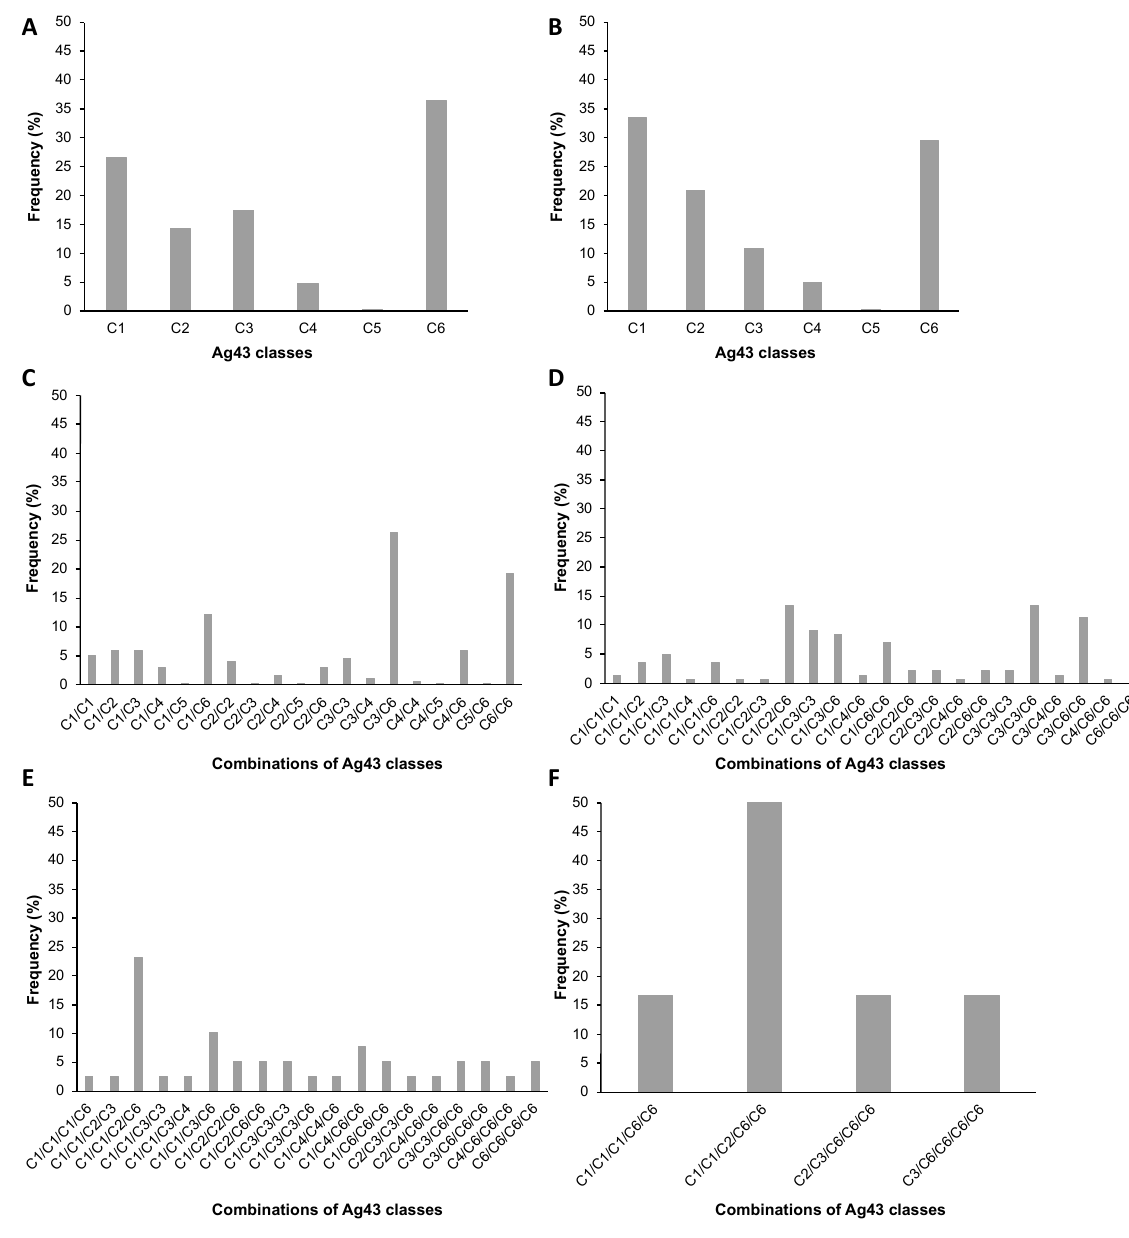
Figure 9. Prevalence and distribution for the different combinations of the 6 Ag43 classes in Escherichia genomes. Representation of the frequency of detection of the different Ag43 classes or combinations of classes in ( A ) all genomes encoding at least one copy of Ag43, ( B ) genomes encoding a single copy of Ag43, ( C ) genomes encoding two copies of Ag43, ( D ) genomes encoding three copies of Ag43, and ( E ) genomes encoding four copies of Ag43, and ( F ) genomes encoding four copies of Ag43 (supplementary Table